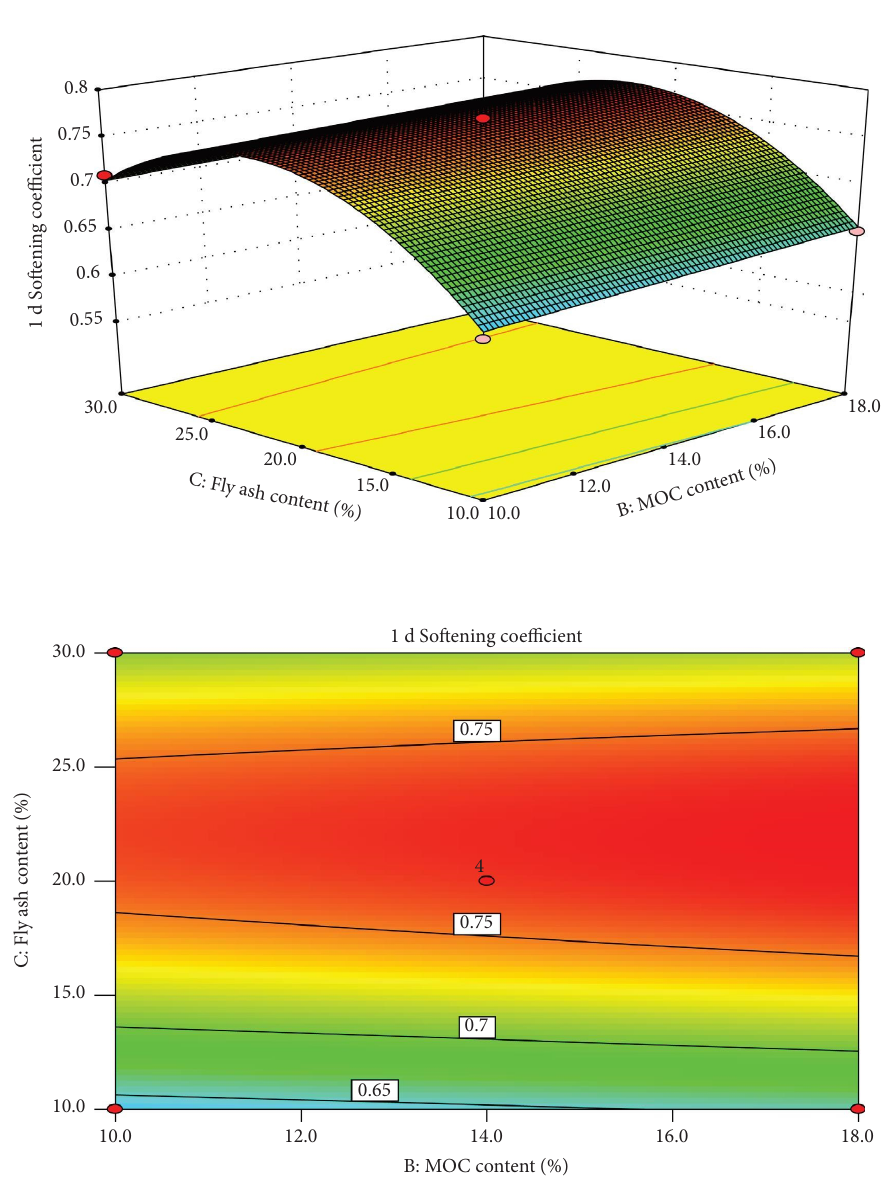
Figure 10: Efect of MOC content, fy ash content, and their interaction on the 1d softening